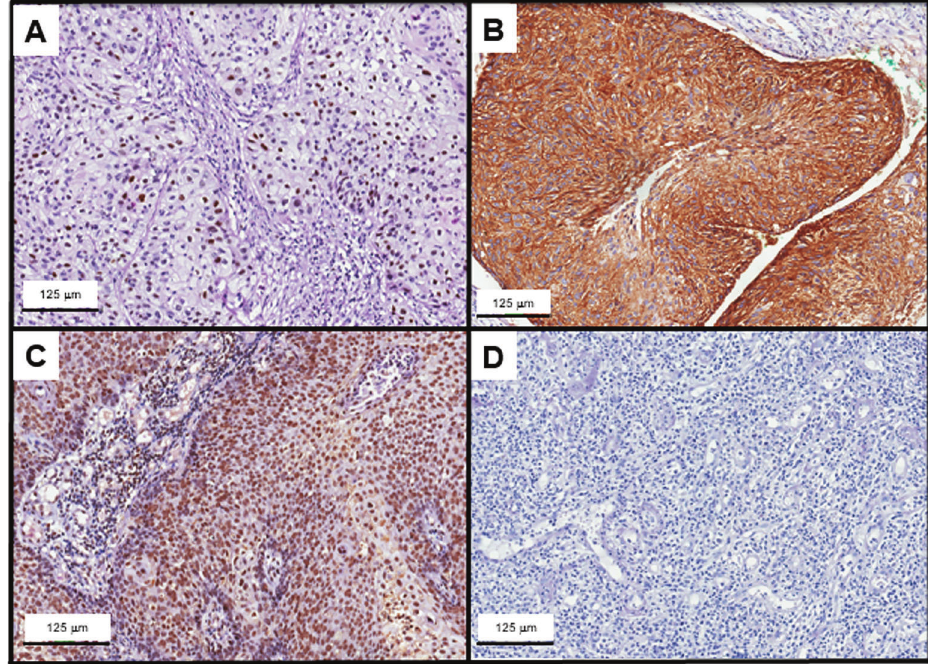
Figure 3. Representative microphotographs of immunohistochemical staining of cervical carcinomas for p53 ( A ), EGFR ( B ), ERCC1 ( C ), and a negative control ( D ). As expected, p53 and ERCC1 staining was con fi ned to the cell nucleus. Original magni fi cation: 100 (cid:3) (scale bar: 125 m m).